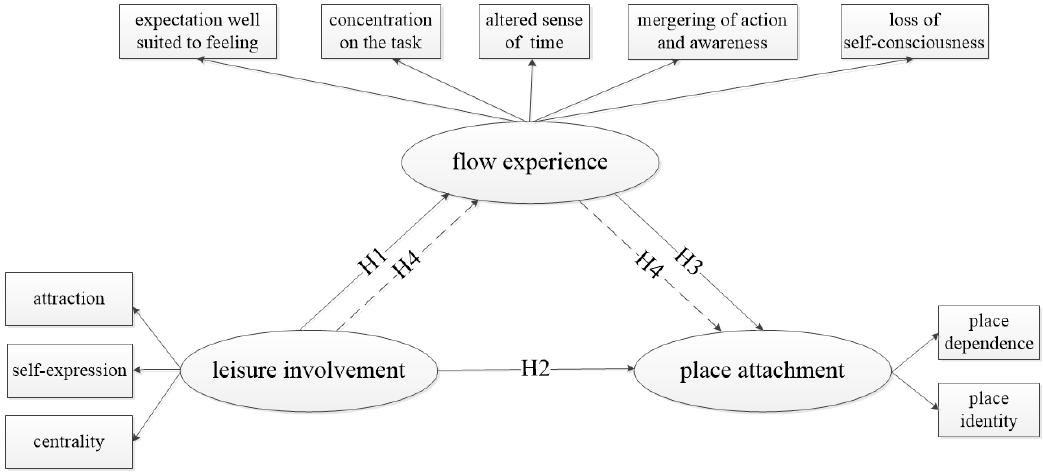
Figure 1. Theoretical framework.